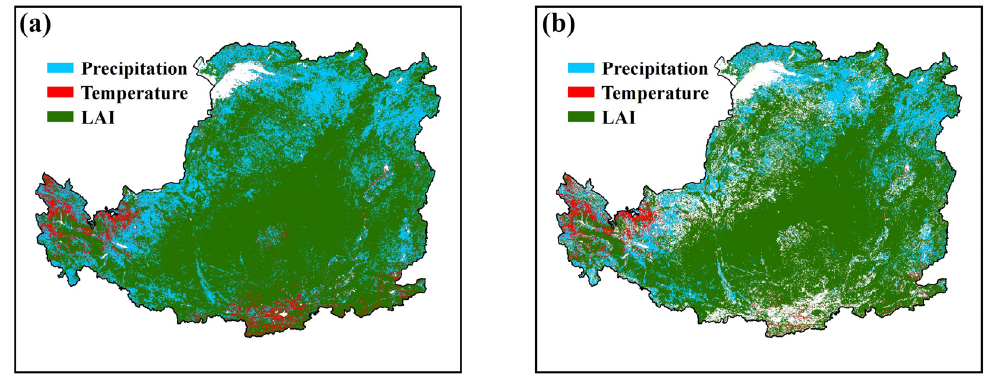
Figure 7. Calculated relative dependence of the ESI on precipitation, temperature and the LAI based on ( a ) multiple regression analysis and ( b ) partial correlation analysis.